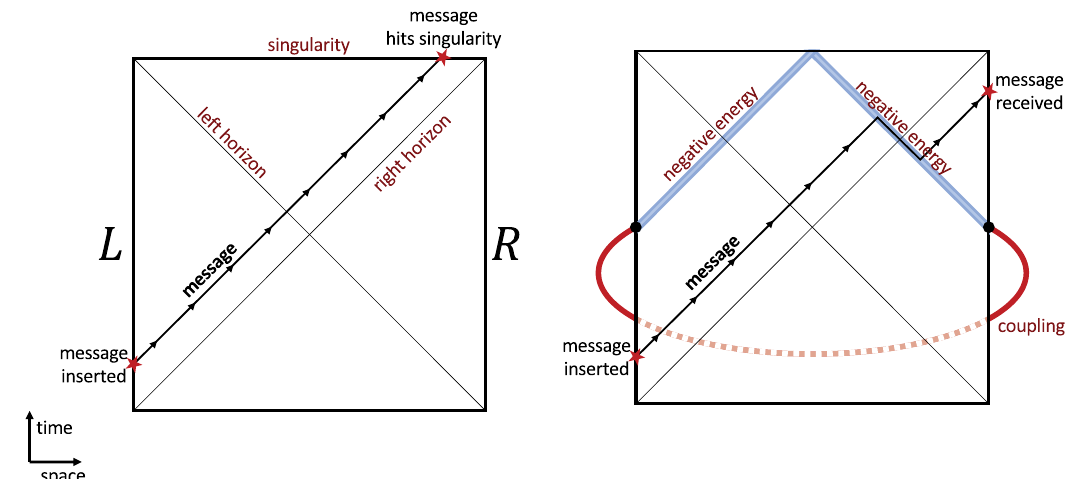
FIG. 2. The Penrose diagram of wormholes. Left: without the coupling, a message or particle inserted at early times on the left passes through the left horizon and hits the singularity (the top line of the diagram). Right: in the presence of the left-right coupling, the message hits the negative-energy shock wave (the thick blue line) created by the coupling. The effect of the collision is to rescue the message from behind the right